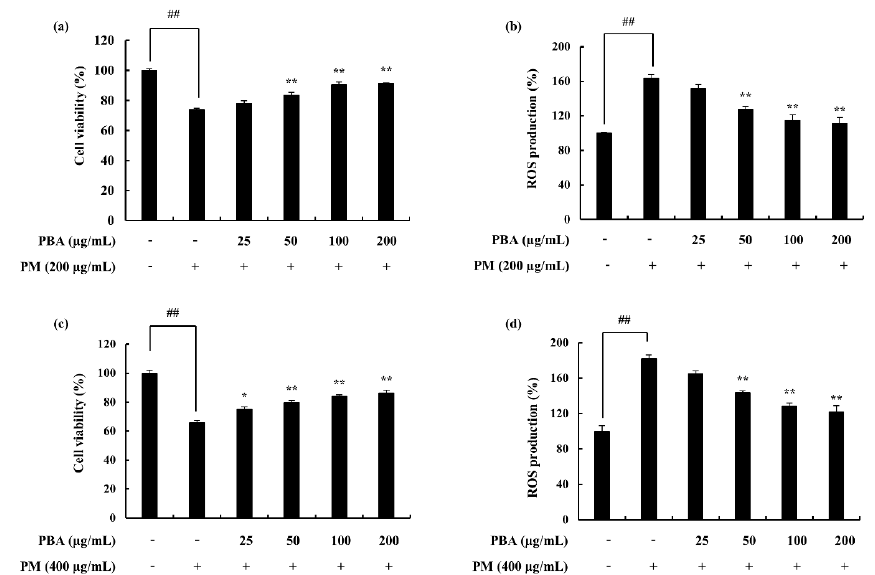
Figure 2. ( a ) PBA cytoprotective effect evaluation, ( b ) ROS production inhibition effect of PBA, in PM-induced keratinocytes, ( c ) Cytoprotective ability of PBA, ( d ) ROS production inhibition effect of PBA, in PM-induced HDF. Triplicated experiments were used to evaluate the data. Results are represented as mean ± SD; * p < 0.05, ** p < 0.01. (# denotes significance compared to control while * represents significance compared to the PM-treated group).